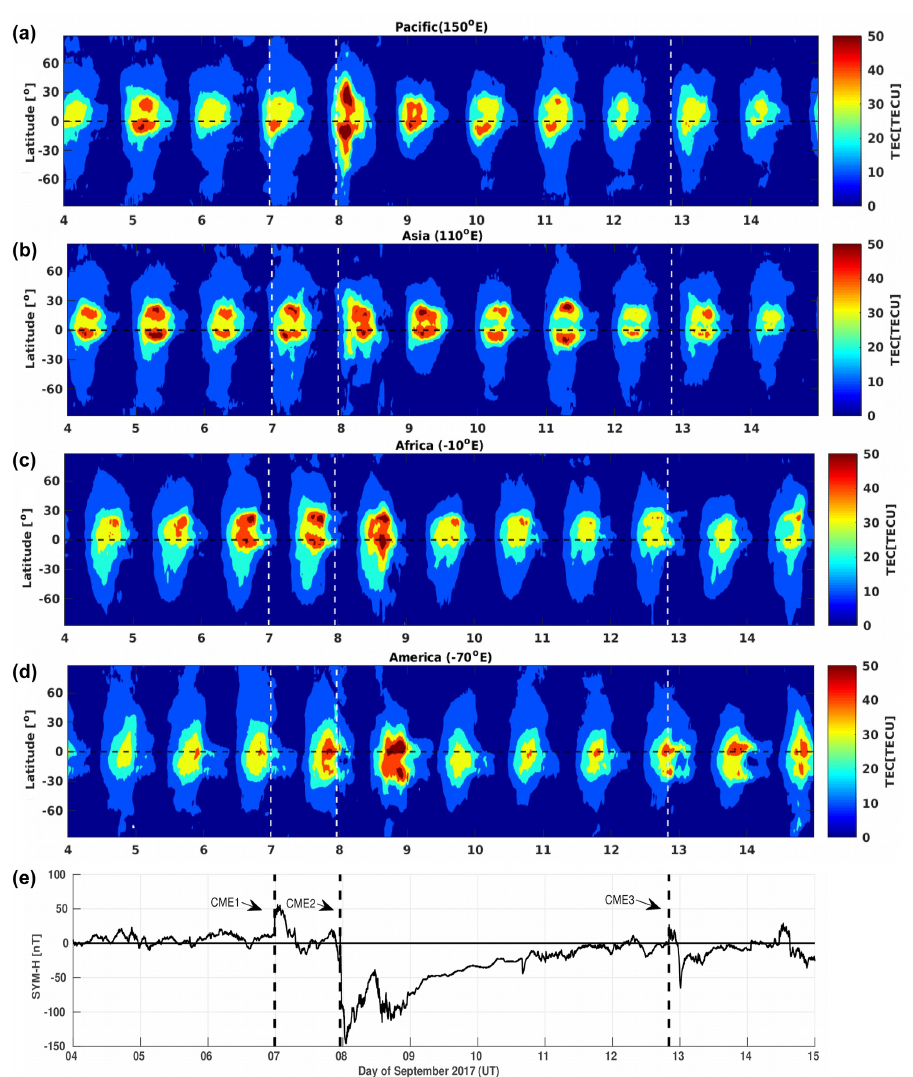
Figure 4. The vTEC variations over the Pacific (a) , Asian (b) , African (c) and American (d) sectors and the SYM-H index (e) during